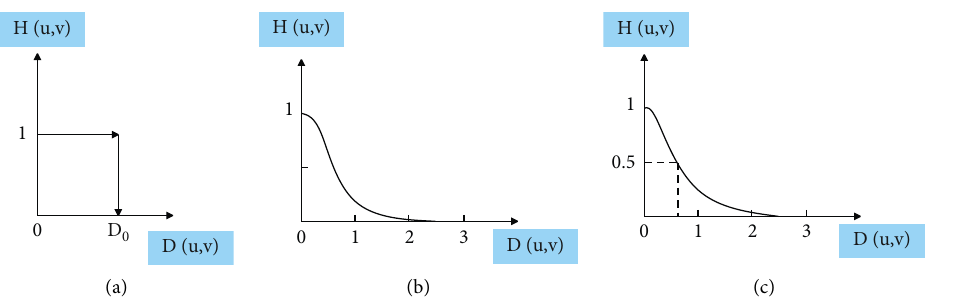
Figure 7: Characteristic curves of three types of low-pass filtering.